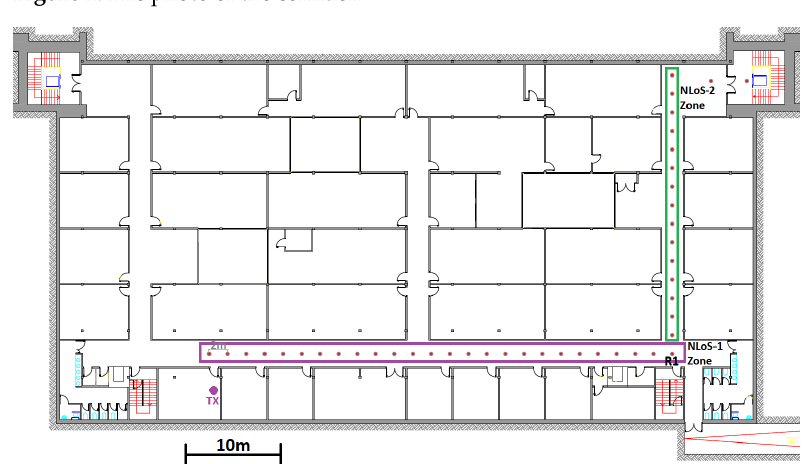
Figure 2. Floor plan underground